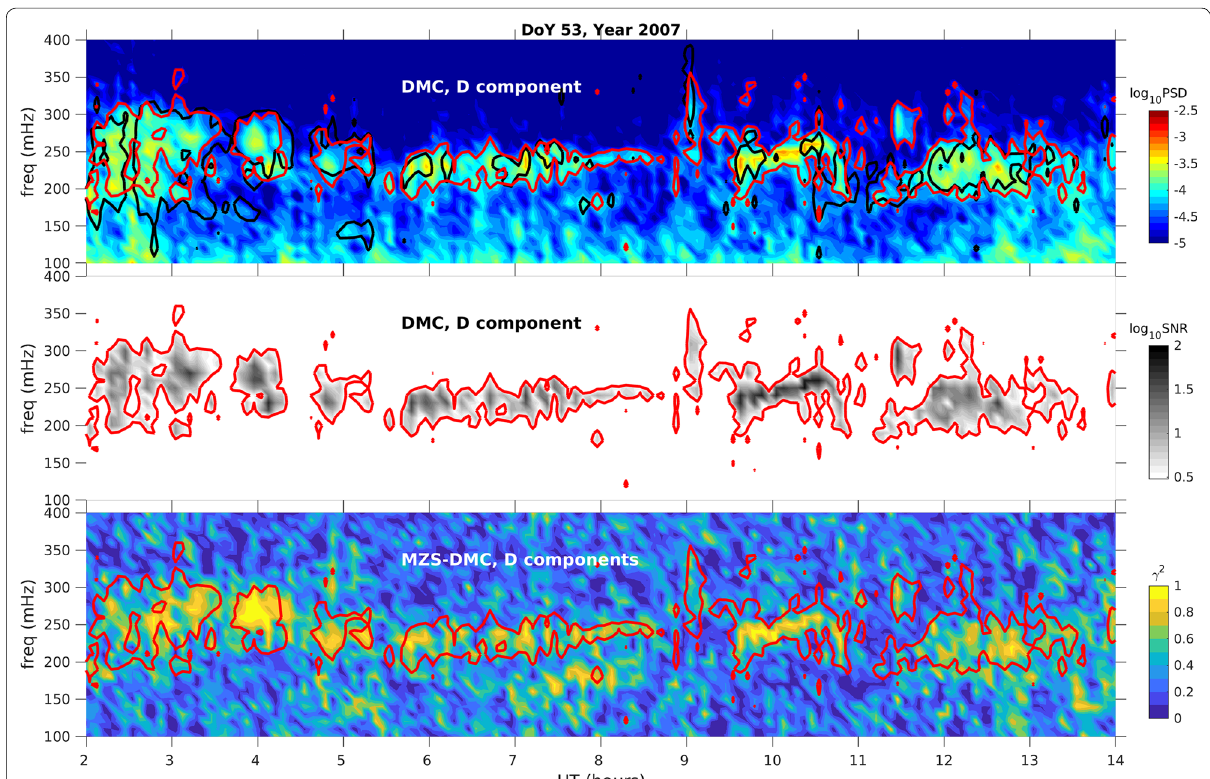
Fig. 5 The dynamical spectrum (top panel) and SNR(f) (middle panel) of Pc1 pulsations at DMC on 22 February 2007 between 0200 and 1400 UT, and the coherence between D components at MZS and DMC (bottom panel). Black and red contours indicate an SNR ( f ) greater than 3 at MZS and DMC,